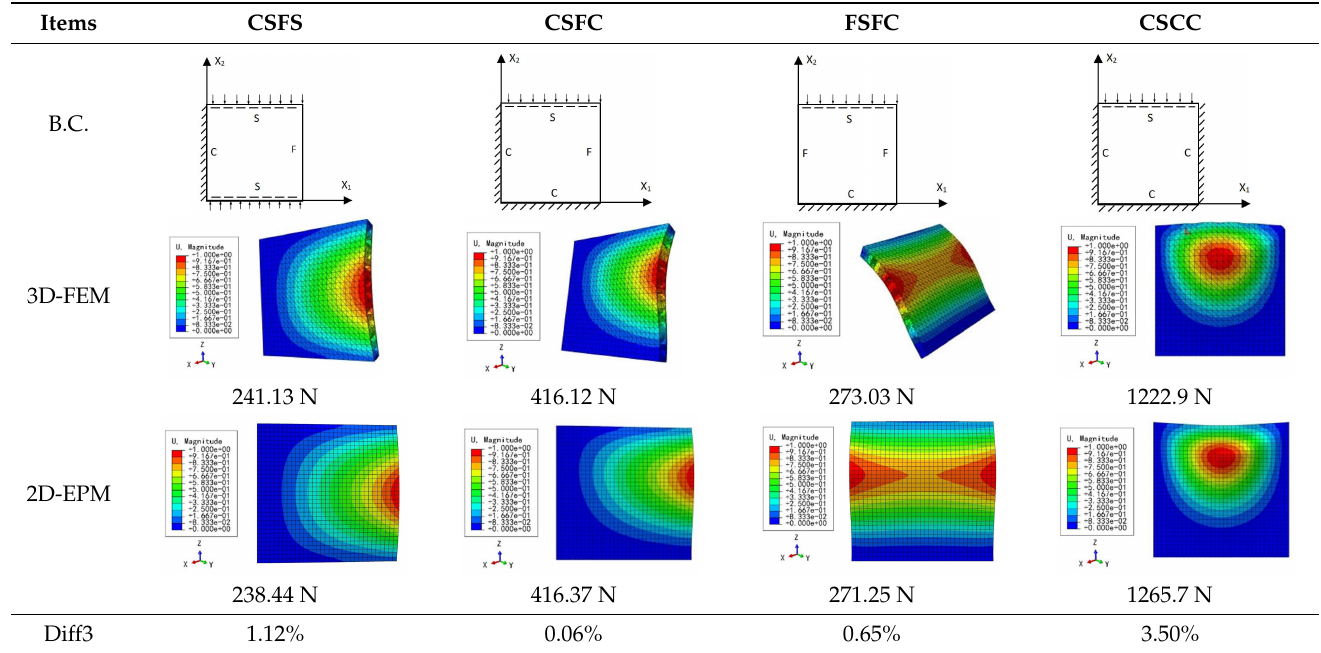
Table 4. Comparison of the buckling modes and loads of the triangular HSP under various boundary conditions predicted by different models.